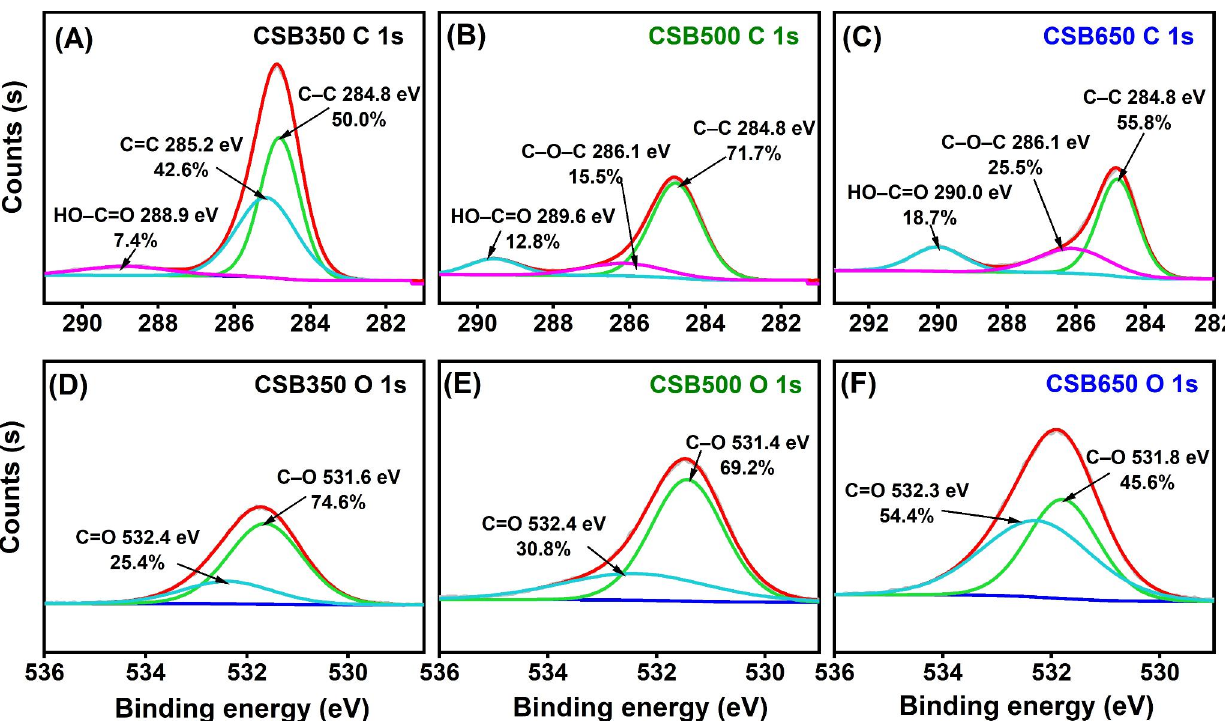
Fig. 2 XPS spectra of C 1s (A, B, C) and O 1s (D, E, F) for crawfish shell biochar (CSB) pyrolyzed at 350 ° C (CSB350), 500 ° C (CSB500), and 650 ° C (CSB650) before